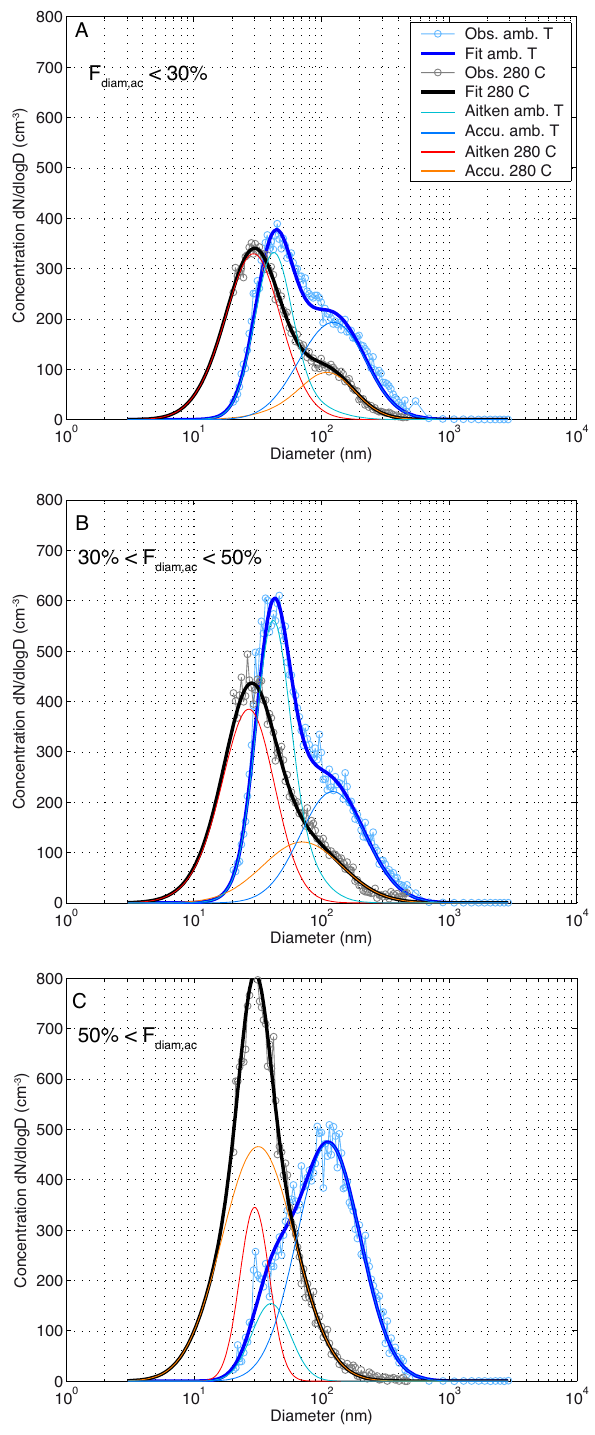
Fig. 10. Ambient and refractory mean aerosol number size distri- butions (in blue and black, respectively) observed (solid line with circles) and fitted (solid line) for the 3 groups classified regarding their F diam , ac values. Aitken and accumulation modes are also in-